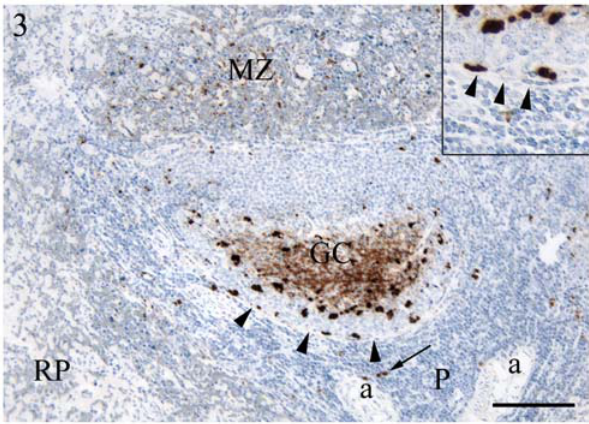
Figure 3. Immunohistochemistry for PrP Sc . Scrapie inoculated sheep. Immunolabelling was most abundant in the light zone of the germinal centre (GC) but a few scattered strongly labelled cells were also present in the dark zone near the outer rim of the lymphoid nodule delineated by spindle-shaped cells (arrowheads, also in inset). In the marginal zone (MZ), an abundant finely granular labelling was prominent and in the PALS (P) a few medium-sized granules (arrow), often close to the arteriole (a), were labelled. RP: red pulp. Bar, 100 m m. Nuclei were stained with haematoxylin.